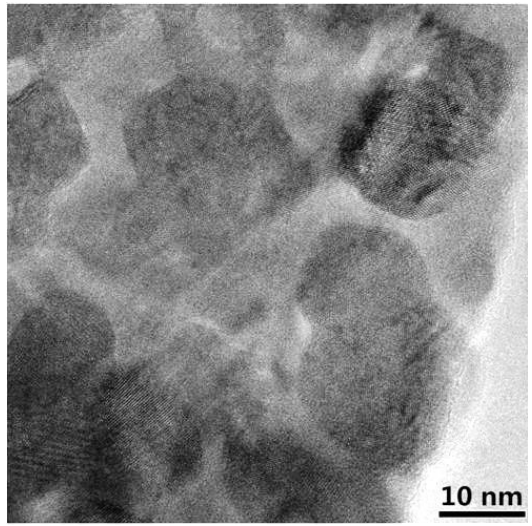
Figure 1. TEM image of as-prepared nc-Ag.